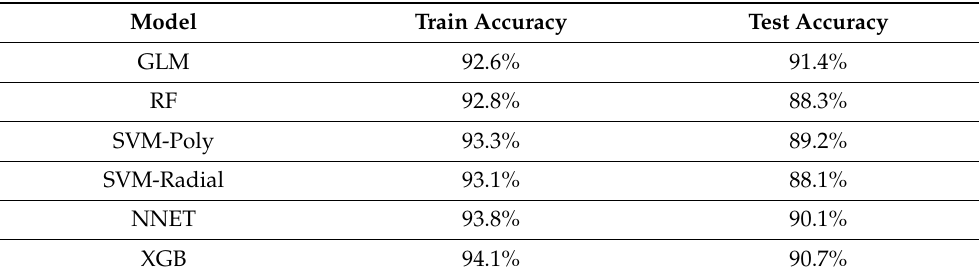
Table 6. Layer-1 Models Performance (IEEE 39-Bus